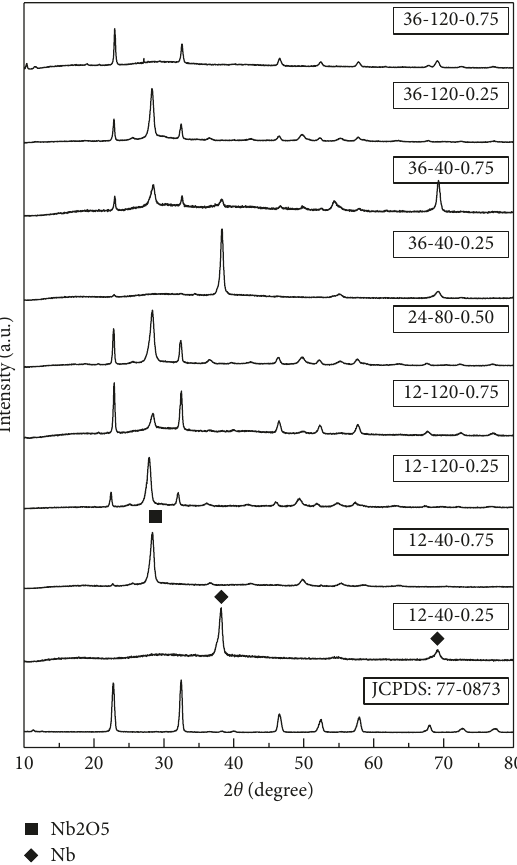
2: X-ray diffraction patterns of the samples synthesized for 12, 24, and 36 hours, at 40 ° C, 80 ° C, and 120 ° C, with NaOH 0.25M, 0.50M, and 0.75M. The standard pattern of orthorhombic NaNbO 3 is depicted in the lower